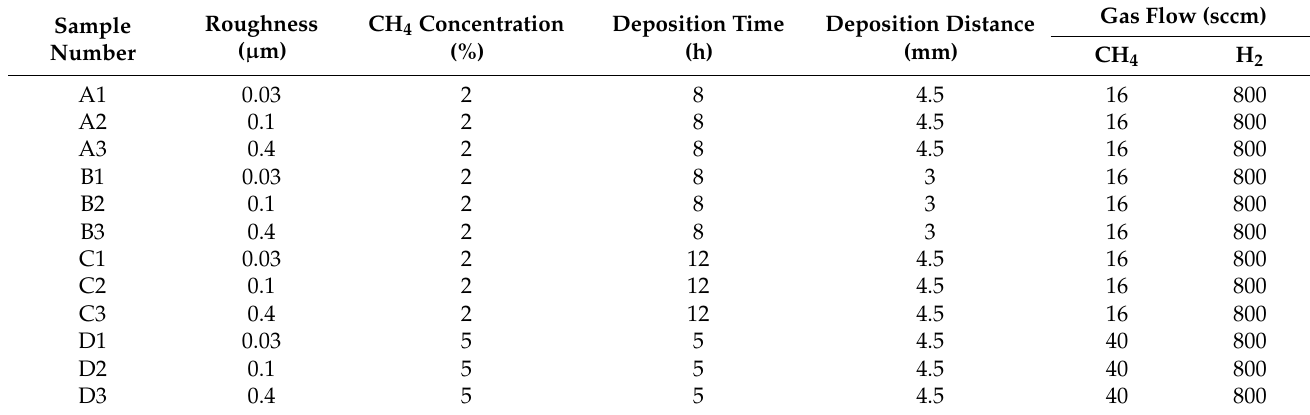
Table 1. Deposition